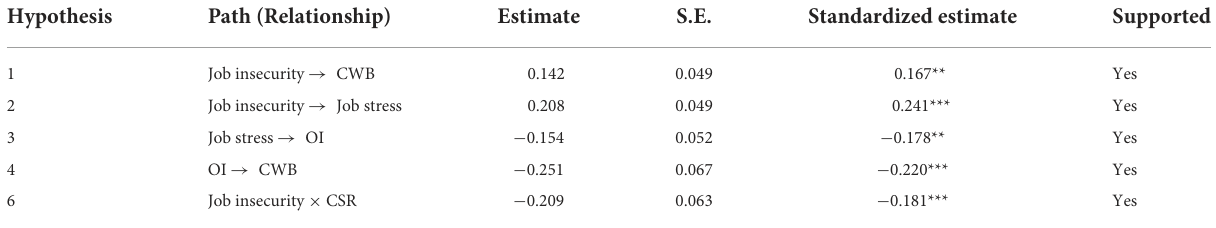
TABLE 3 Results of the structural